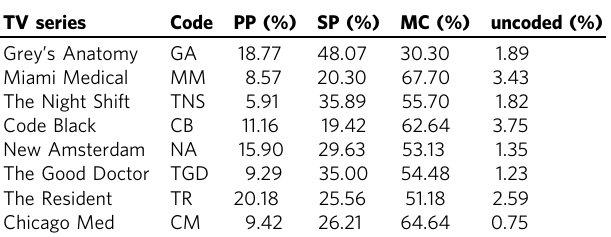
the fi gure is 67%. The remaining fi ve series ( Chicago Med , The belong to the same branch of the dendrogram but are split into two clusters. Speci fi cally, the cluster of Chicago Med , The Night Shift , and The Good Doctor differs from that of New Amsterdam and The Resident primarily in the professional plot. In Chicago